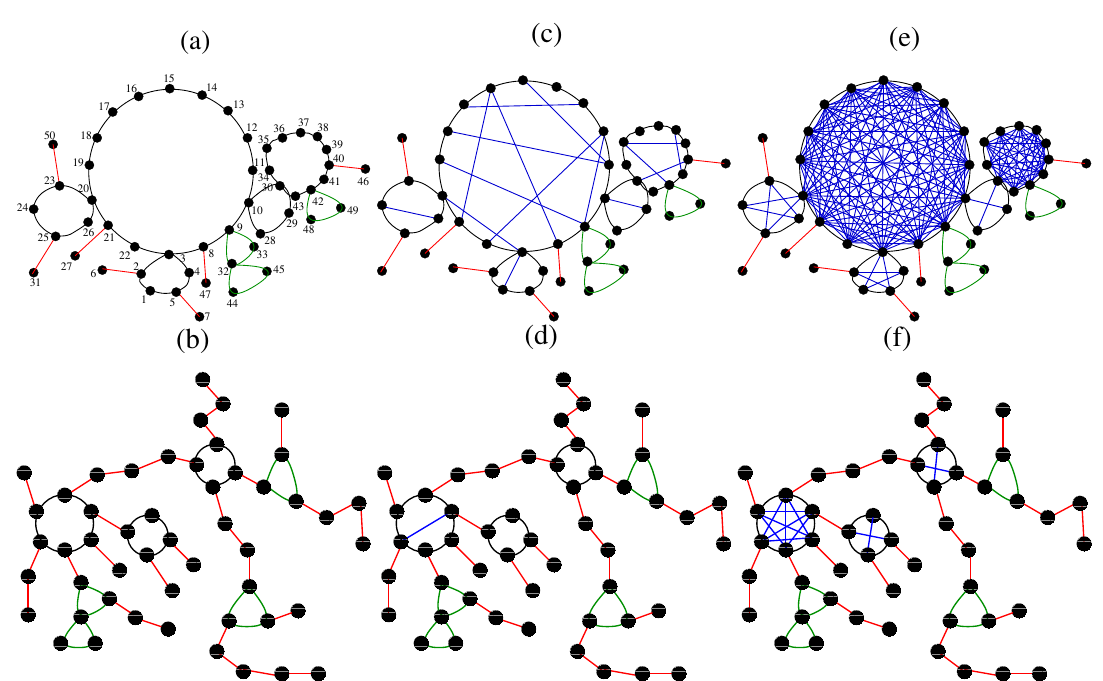
Figure 1. Some realizations of sequentially growing dual scale-free networks with N = 50 nodes and ( a , b ) p = 0 (ring-based dual scale-free network, rDSFN), ( c , d ) p = 0.1 (partially dual scale-free network, pDSFN), and ( e , f ) p = 1 (complete-graph based dual scale-free network, cDSFN). The upper row ( a , c , e ) corresponds to networks with γ = 2.5, and the lower row ( b , d , f ) is for γ =